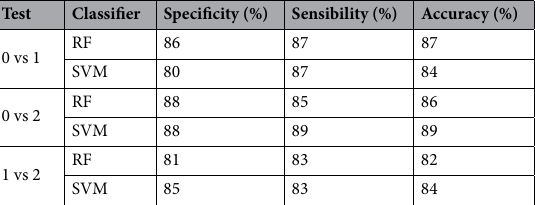
Test Classifier Specificity (%) Sensibility (%) Accuracy (%)